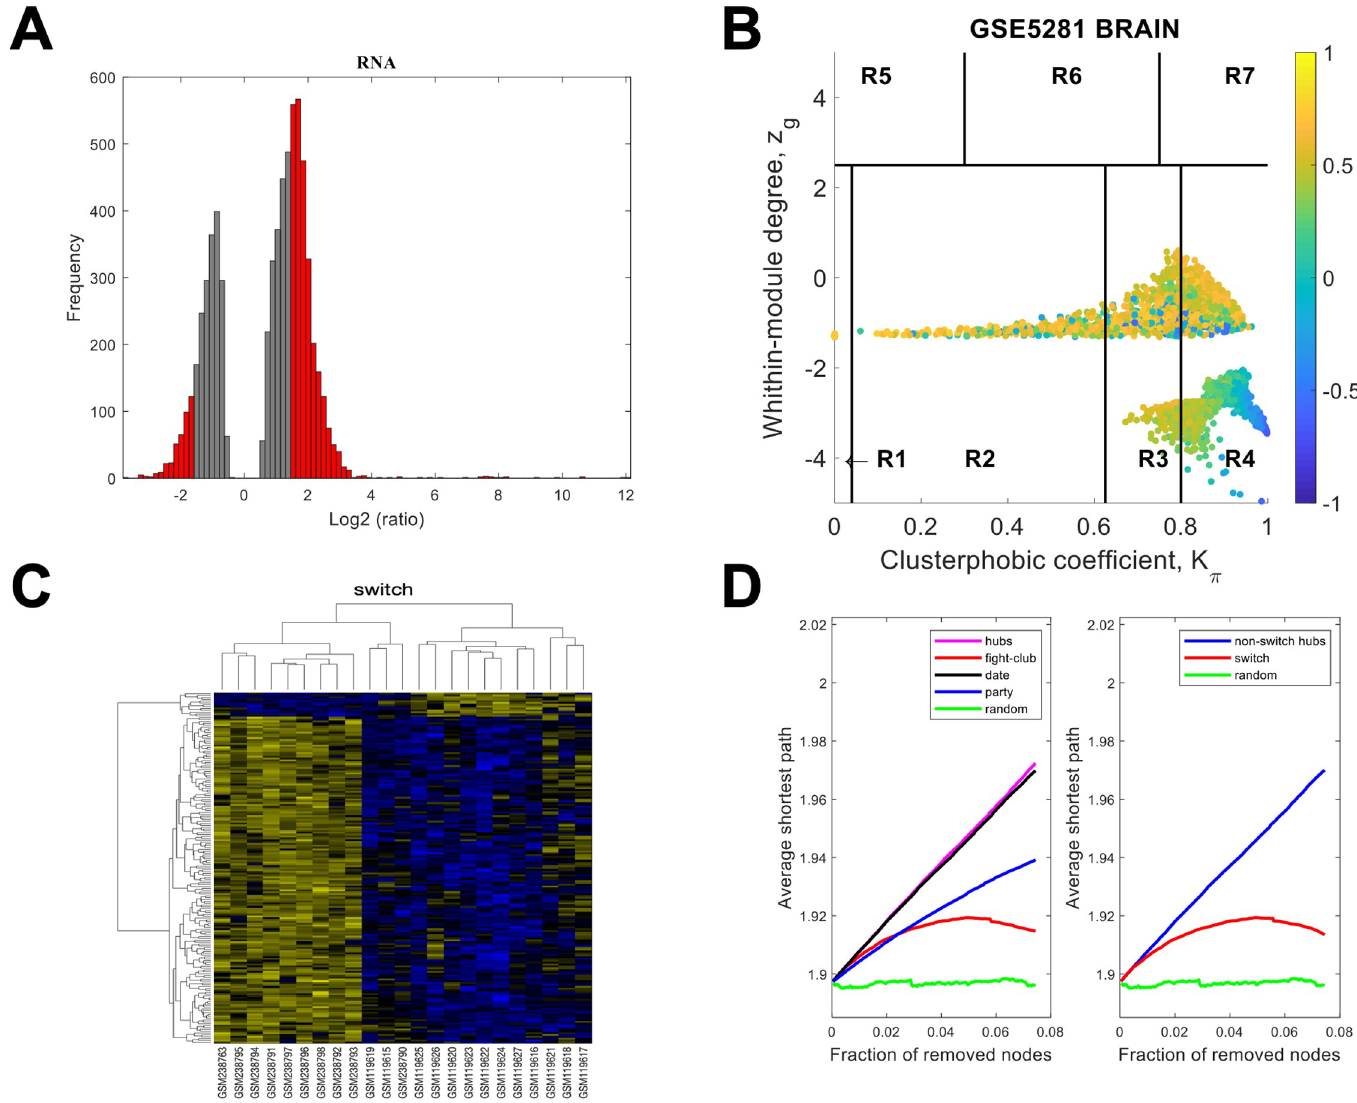
Fig 3. SWIM analysis of the entorhinal cortex. A. Distribution of the fold-change values for GSE5281 brain microarray gene expression data from the EC. The x-axis represents the fold-change value (log2 of the fold-change) that is the ratio of the average expression data in AD patients compared to the average expression data in normal controls computed for protein-coding and non-coding RNAs. The y-axis represents the frequency of the obtained fold-change values. The grey bars represent the fold- change values associated with protein-coding and non-coding RNAs that will be discarded according to the selected threshold. The red bars represent the fold-change values associated with protein-coding and non-coding RNAs that were retained for further analysis. B. Heat cartography map for GSE5281 brain data from the entorhinal cortex correlation network. The plane is identified by two parameters: Zg (within-module degree) and Kπ (clusterphobic coefficient) and it is divided into seven regions each defining a specific node role (R1-R7). High Zg values correspond to nodes that are hubs within their module (local hubs), whereas low Zg values correspond to nodes with few connections within their module (non-hubs within their communities, but they could be hubs in the network). Each node is colored according to its average Pearson Correlation coefficient (APCC) value. Yellow nodes are party and date hubs, which are positively correlated in expression with their interaction partners. Blue nodes are the fight-club hubs, which have an average negative correlation in expression with their interaction partners. Blue nodes falling in the region R4 are the switch genes, which are characterized by low Zg and by high Kπ values and are connected mainly outside their module. C. Dendrogram and heat map for switch genes in GSE5281 brain microarray gene expression data from the entorhinal cortex. The expression profiles of switch genes (including protein-coding and non-coding RNAs) are clustered according to rows (switch genes) and columns (samples) of the switch genes expression data (biclustering). The colors represent different expression levels that increase from blue to yellow. The red line under the x axis labels denotes AD samples. D. Robustness for the GSE5281 brain correlation network from the entorhinal cortex. The x-axis represents the cumulative fraction of removed nodes, while the y-axis represents the average shortest path. The shortest path between two nodes is the minimum number of consecutive edges connecting them. Each curve corresponds to the variation of the average shortest path of the correlation network as function of the removal of nodes specified by the colors of each